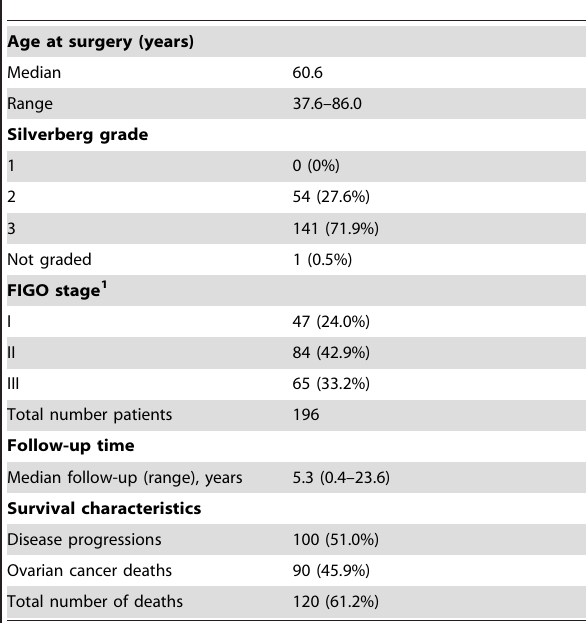
Table 1. Patient characteristics, follow-up time and survival characteristics for high-grade serous ovarian carcinoma cases.